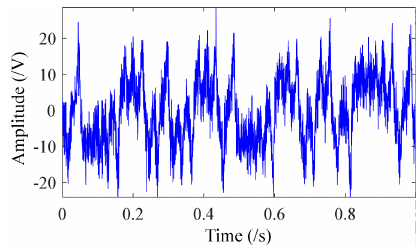
Figure 7. Time domain plot of Lorenz with noise.